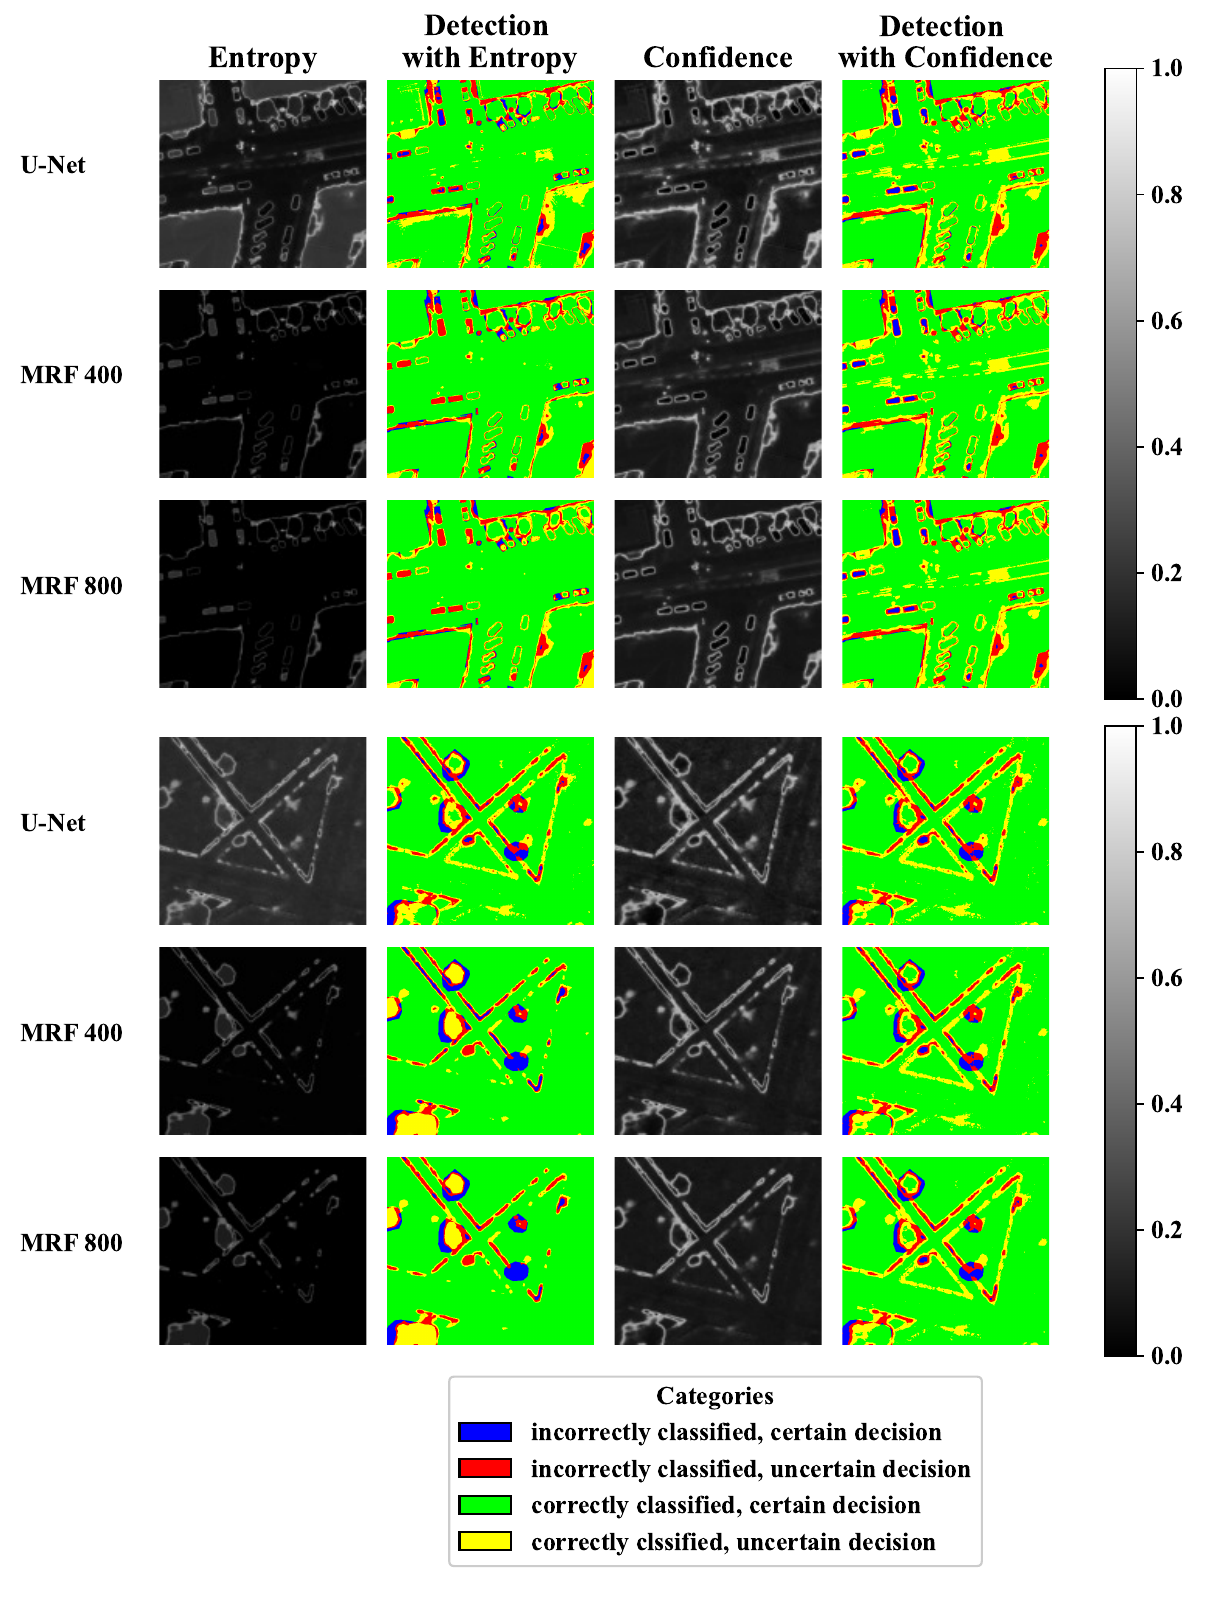
Figure 5. Uncertainty and detection maps for both image fragments of Figure 2. The entropy H 1 from (3) and H 2 from (4) for the choices U-Net, MRF400 and MRF800 are shown in first and third columns, respectively. For detection maps (second and fourth columns) uncertainty masks are compared with ground truth. A distinction is made between uncertain and certain pixels in combination with correct and incorrect